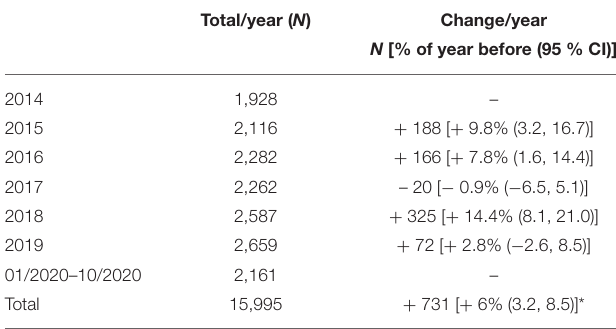
TABLE 2 | The number of tumor board presentations per year from 2014 to 2020 and change compared with the previous year.